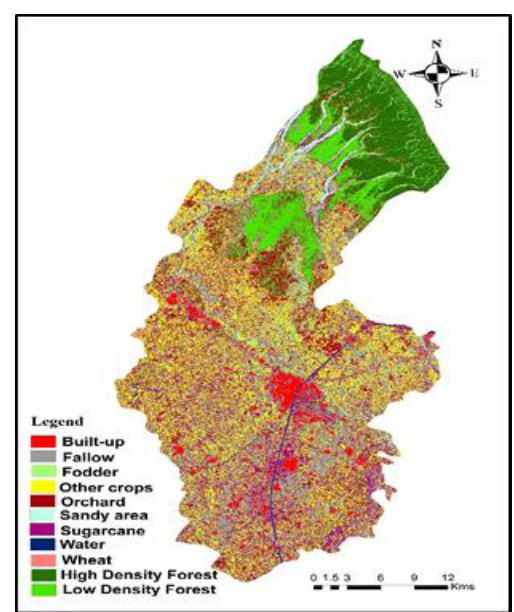
Figure 4 classified image by SVM.